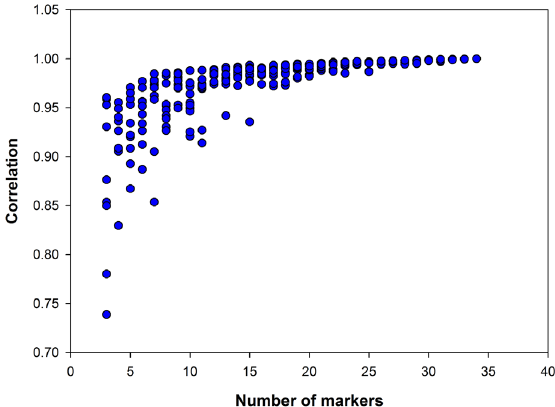
Figure 1. Optimal number of microsatellite markers analyzed in 94 individuals originating from five populations obtained from interspecific crosses of Psidium